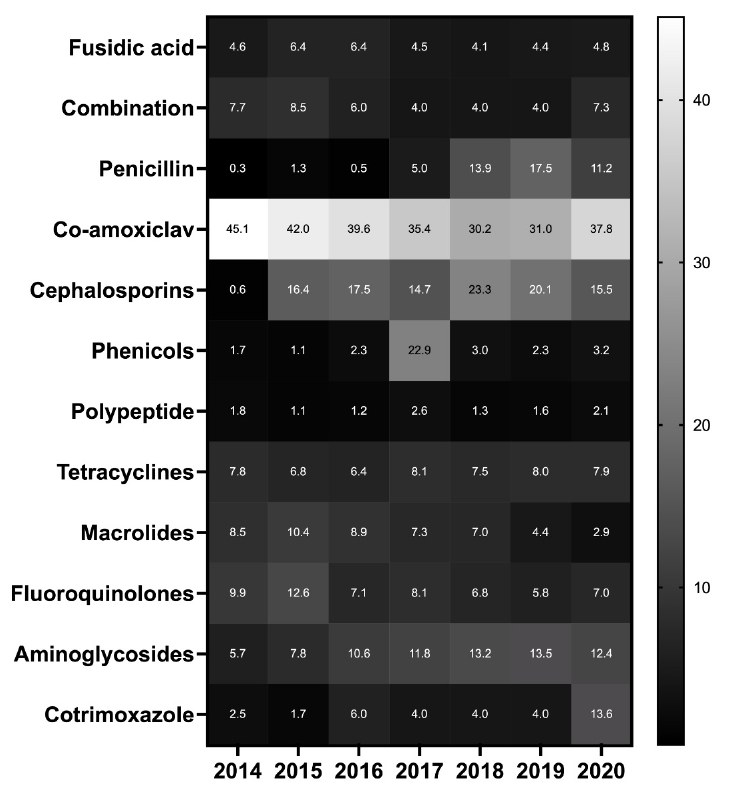
Figure 3. Distribution of class of antibiotic—all species combined—from 2014 to 2020, regardless of route of administration and pathology.